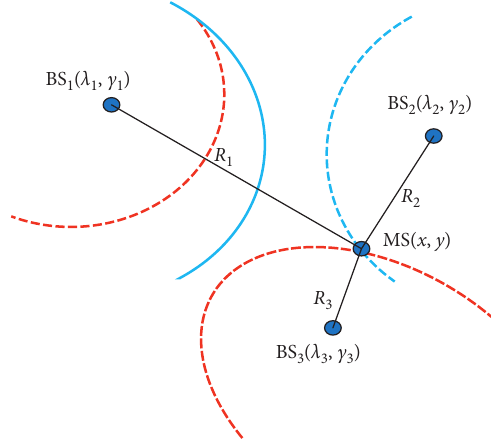
Figure 4: TDOA hyperbolic positioning.